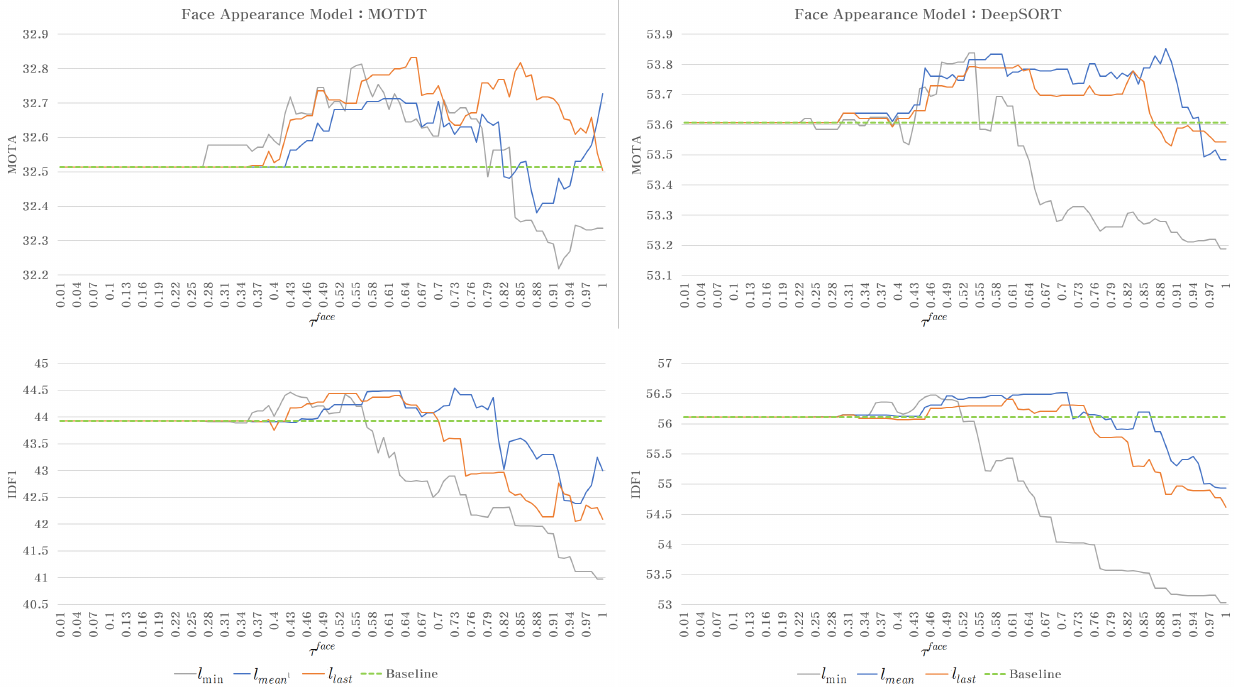
Figure 14. Experimental results to validate our proposed face appearance model. Specifically, the color of each line represents the corresponding distance